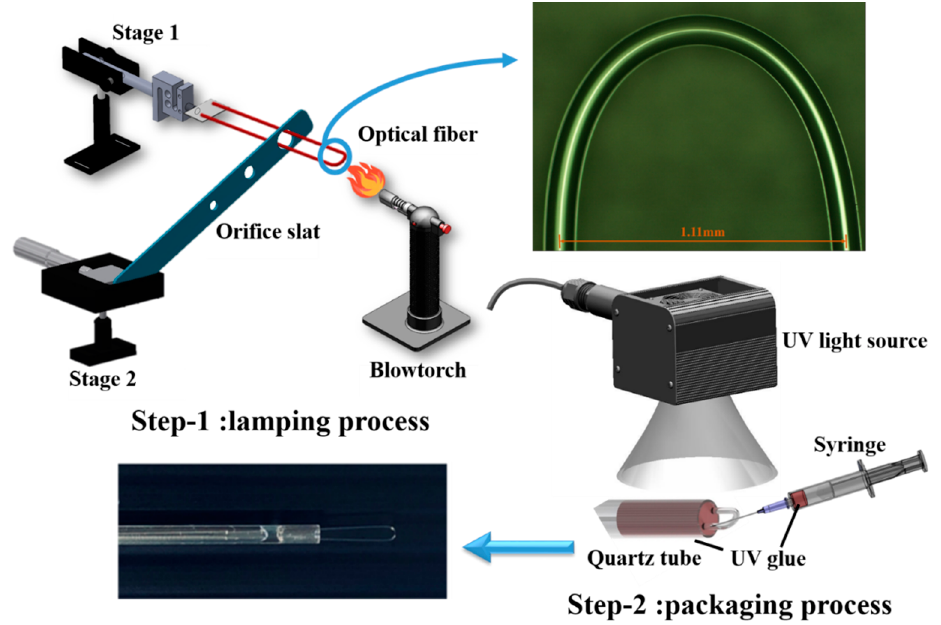
Figure 1. Schematic diagram of fabrication process divided into two steps including the lamping process and packaging process. The optical microscope image shows that the diameter of the semicircular region of fabricated U-shaped optical fiber is 1.11 mm.